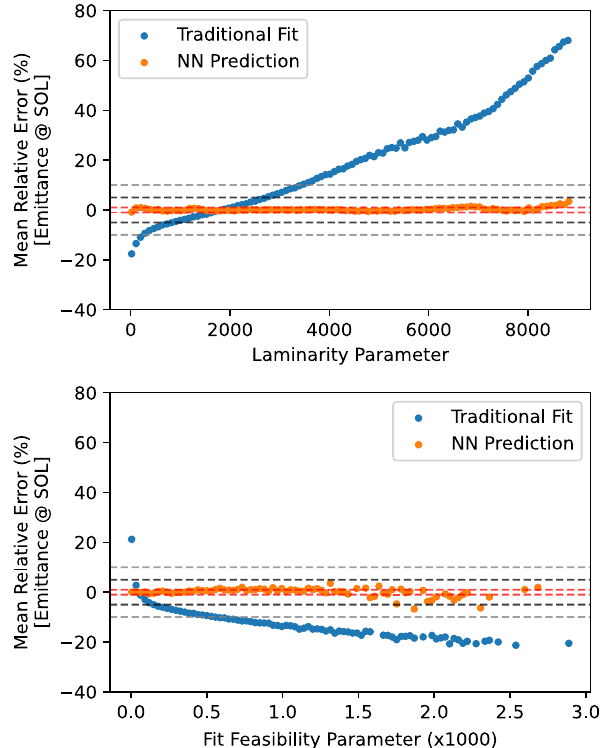
FIG. 7. Mean emittance FCNN prediction performance, as well as traditional fit results vs the laminarity parameter (top) and the fit feasibility criterion (bottom). The data are calculated for 100 equally sized laminarity parameter slices. γ ¼ 6 . 8 for this population. Note that the bottom plot shows the fit criterion values multiplied by 1000 for readability .